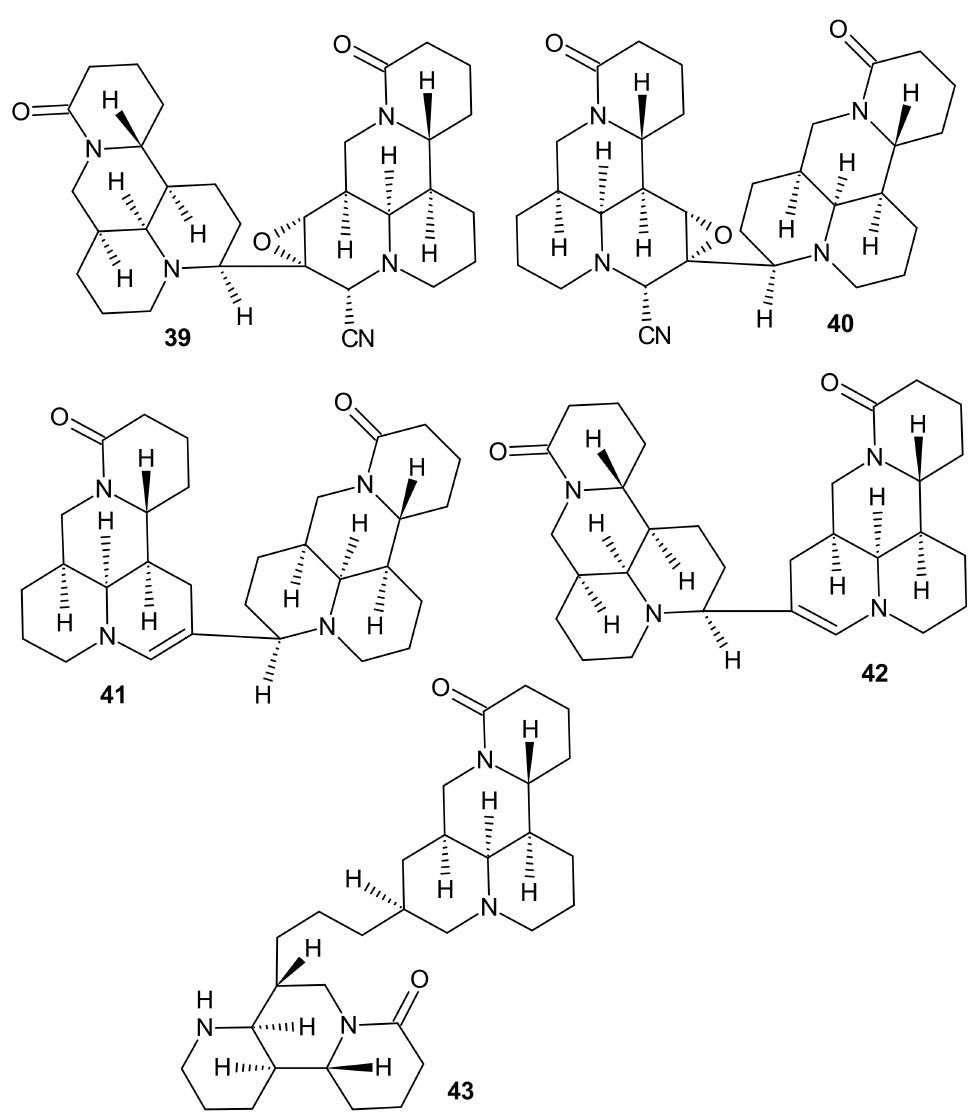
Figure 13. Alopecuroides A − E 39 – 43